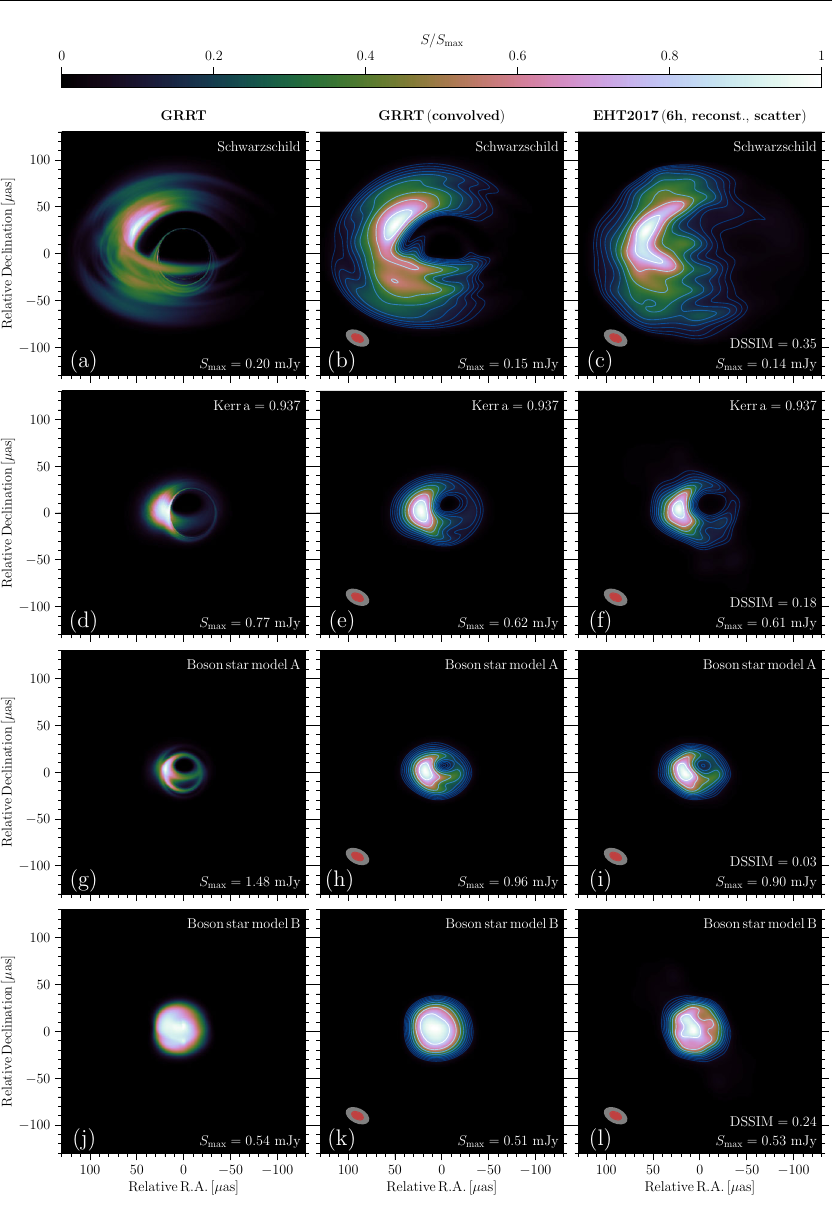
Fig. 31 Synthetic images of various compact objects (Schwarzschild and Kerr black holes and two different boson stars). Note that the central dark area of the BSs is smaller than the black hole cases and that the BS images are more symmetric. Reproduced with permission from Olivares et al. (2020), copyright by the